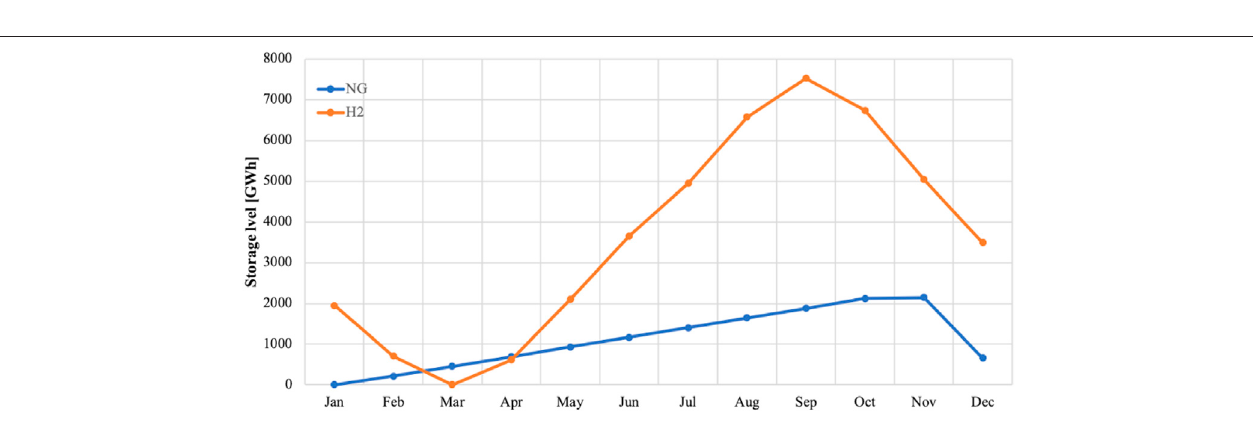
FIGURE 7 | Seasonal storage levels of natural gas and hydrogen